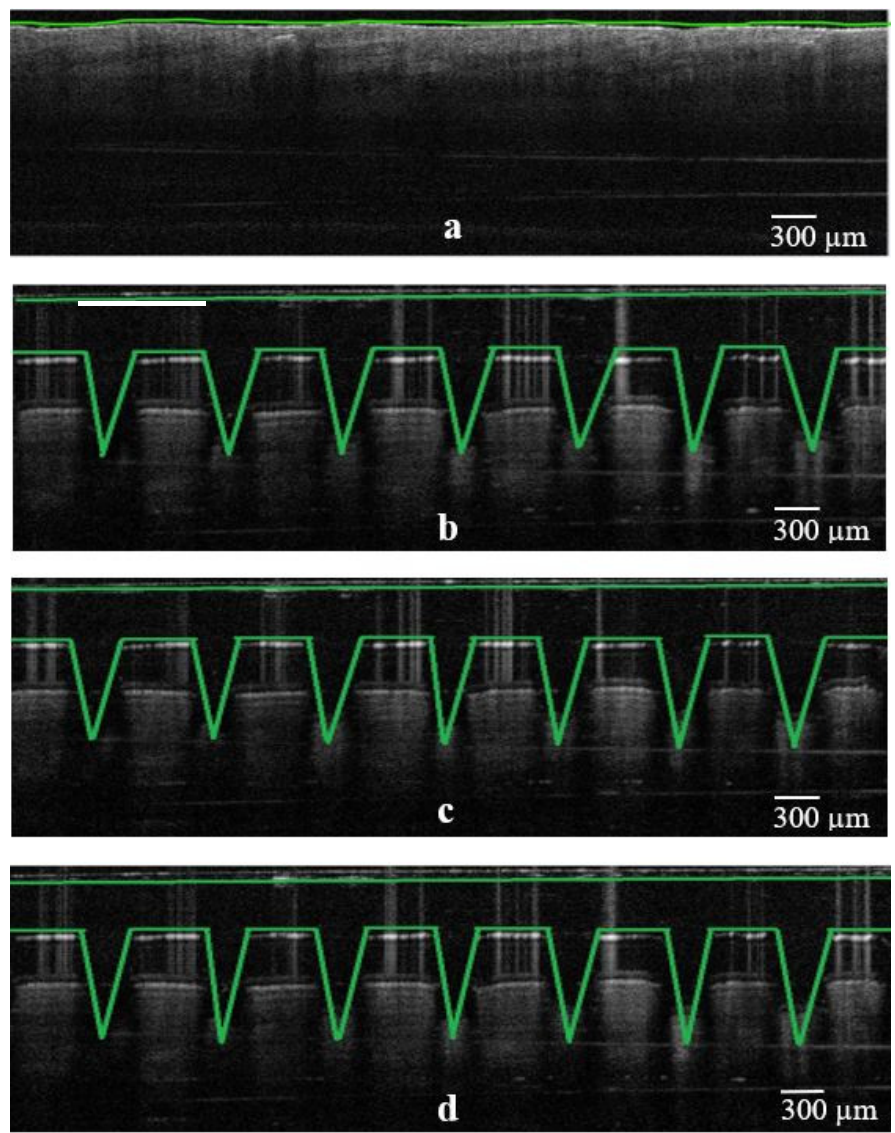
Figure 6. False color 2D still images of 3D-printed MNs (cone design; C1, C2 and C3) showing the real-time penetration into the mouse skin using OCT. ( a ) Skin sample as control before experiment; ( b ) insertion of C1 design; ( c ) insertion of C2 design; ( d ) insertion of C3 design, respectively (scale bar 300 μ m).